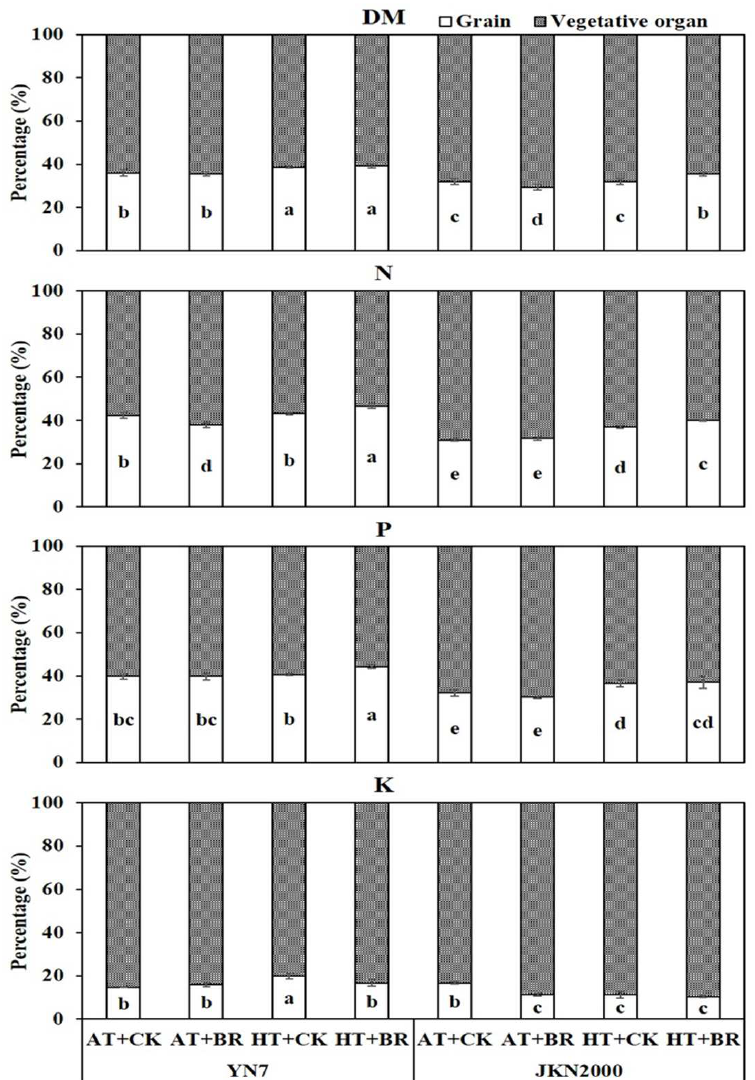
Figure 5. Effects of exogenous BR application at the silking stage on the harvest index of DM and nutrients of waxy maize under post–silking ambient and high temperatures. YN7, Yunuo7; JKN2000, Jingkenuo2000; AT, ambient temperature; HT, high temperature; CK, control, plants sprayed with 100 mL water; BR, brassinolide, plants sprayed with 100 mL 0.25 mg/L BR. Within columns, those followed by the same letters are not significantly different ( p <